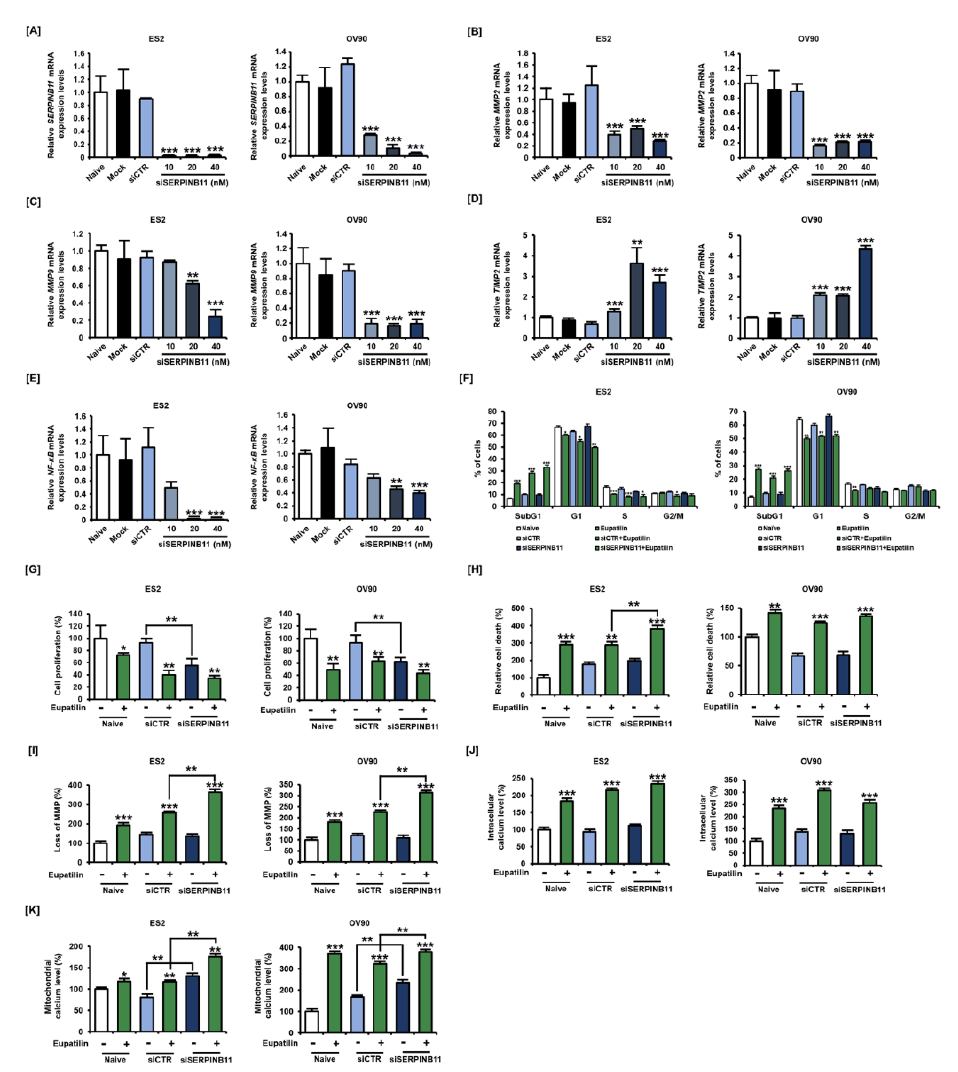
Figure 6. The functional role of SERPINB11 knockdown in the transcriptional levels of ovarian cancer- associated genes and anticancer activity by eupatilin in ovarian cancer cells. ( A ) Dose-dependent inhibition of SERPINB11 using specific target siRNA by transfection using Lipofectamine 2000. ES2 and OV90 cells were transfected with transfection reagent alone (Mock), non-specific control siRNA (siCTR), and naïve cells were used as negative controls. ( B – E ) In the absence of SERPINB11 via siSERPINB11 transfection, transcriptional levels of ovarian-cancer-associated genes MMP2 [B], MMP9 ( C ), TIMP2 ( D ), and NF- κB ( E ) were evaluated in ES2 and OV90 cells. ( F ) Ovarian cancer cells were treated with an optimal co ncentration of eupatilin (50 μM) under the presence or absence of SERPINB11, and PI-dependent DNA content was analyzed by flow cytometer to estimate cell cycle distribution. ( G – H ) Anti-proliferative effects ( G ) and apoptosis induced ( H ) by eupatilin under SERPINB11 abrogation in ES2 and OV90 cells. ( I ) After eupatilin treatment, the loss of MMP was analyzed by the ratio of red and green fluorescence by JC-1 staining under the presence or absence of SERPINB11. ( J – K ) Intracellular ( J ) and mitochondrial calcium ( K ) levels were measured by Fluo-4 and Rhod-2 fluorescence intensity, respectively, under the presence or absence of SERPINB11 in ES2 and OV90 cells. The experiments were performed in triplicate. Data represent the mean ± standard deviation, and asterisks indicate that the effect of treatment was statistically significant (* p < 0.05, ** p < 0.01, and *** p <